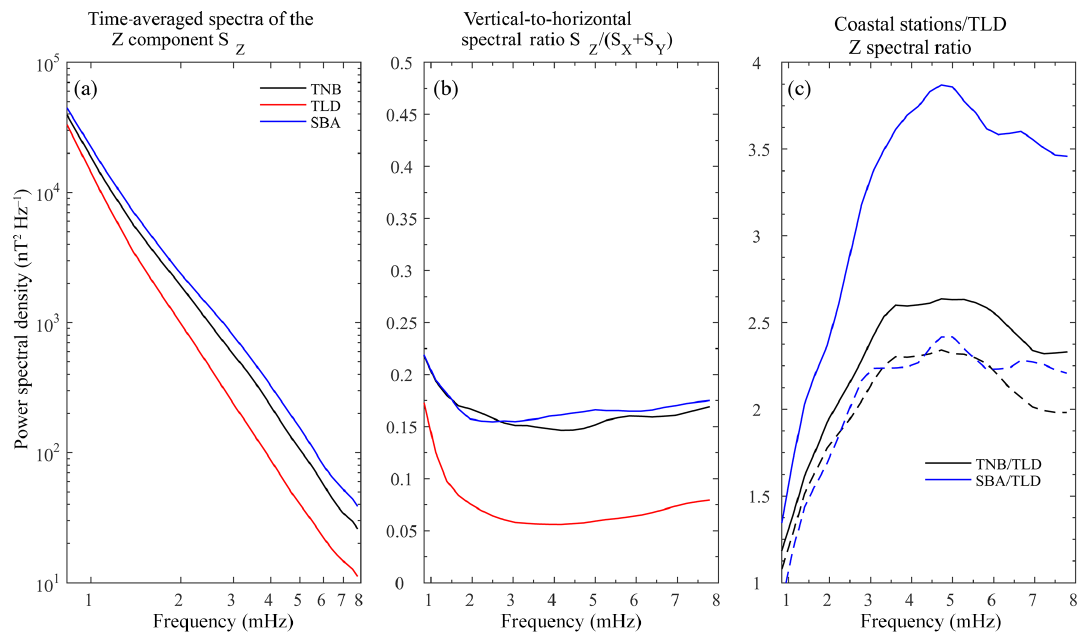
Figure 2. Average spectral density of the Z component (a) and spectral ratio Z/(X + Y) (b) at each geomagnetic station; spectral ratio of the Z components at each coastal station and at TLD ( c ; dashed lines during disturbed magnetospheric conditions).